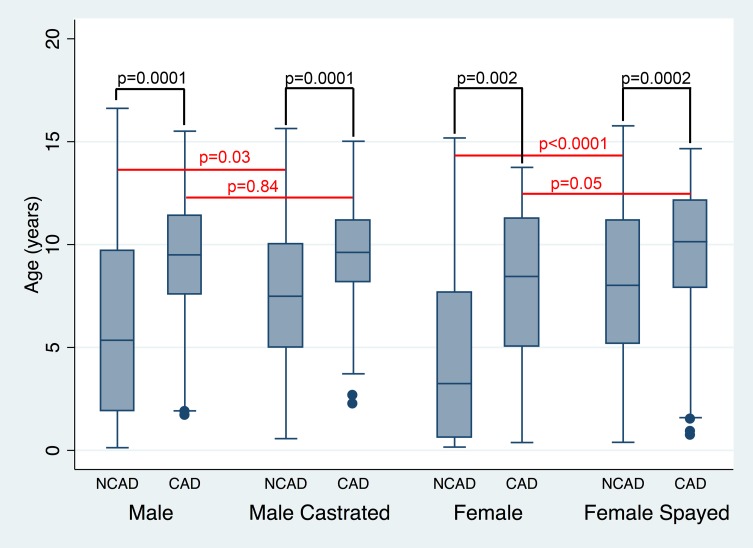
Age of golden retrievers broken out by sex and cause of death.Box and whisker plot showing median age, interquartile range, adjacent values and outliers of golden retriever dogs who underwent a necropsy exam and an attributable or non-attributable death from cancer categorized by sex and spay or neuter status. P values are shown for differences between cancer and non-cancer attributed deaths within each sex category and for differences between sex category within the cancer and non-cancer attributed death groups. NCAD = non-cancer attributable death, CAD = Cancer attributable death.